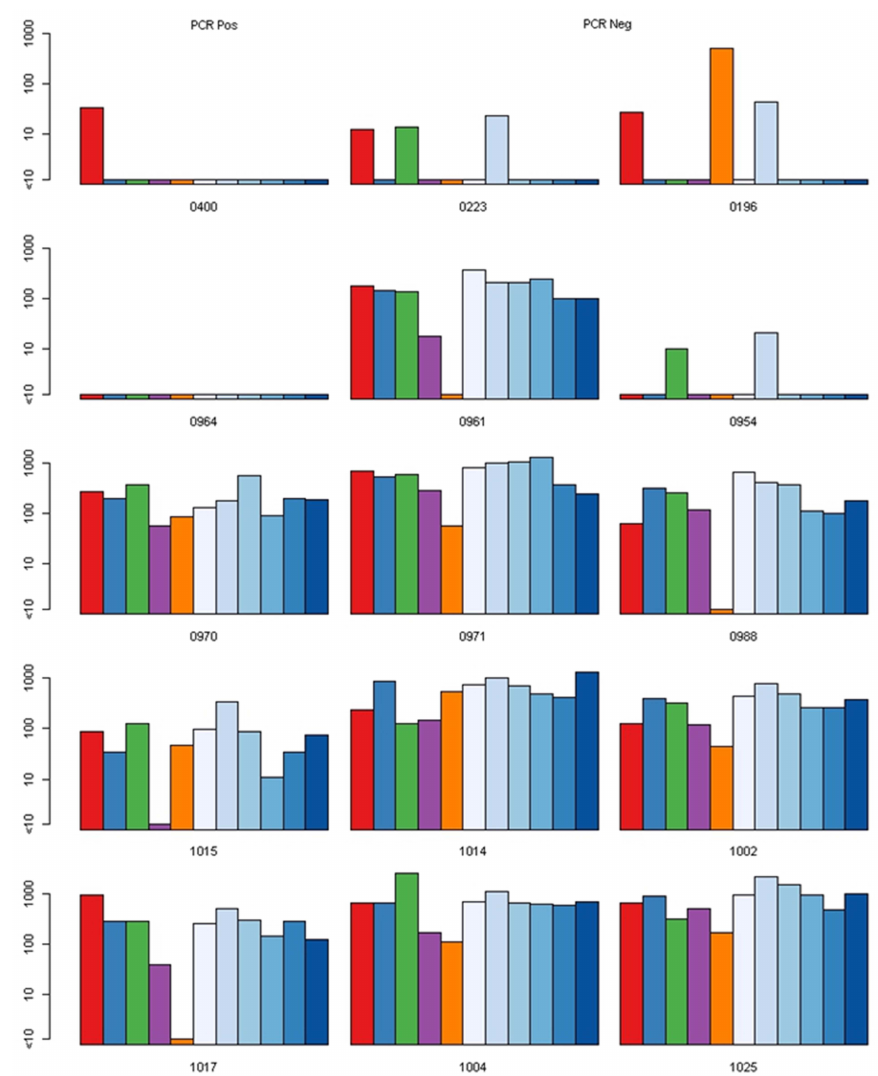
Figure 3. Pre-exposure neutralizing antibody titers (NTs) in dengue virus serotype 2 (DENV-2) ‘‘susceptible’’ and ‘‘non-susceptible’’ subjects. Each row shows one PCR positive (‘‘susceptible’’) subject and two matched PCR negative (‘‘non-susceptible’’) subjects. NTs for each subject are against (in order from left to right for each subject) the reference strains for DENV-1, -2, -3, -4 and Japanese encephalitis virus (JEV), and six different DENV-2 strains (Asian-American 1982 [ # D82-165], Asian I 1974 [ # D74-066], Asian I 1984 [ # D84-501], Asian I 1994 [ # D94-035], Asian I 2004 [ # KDS00305]), and homologous DENV-2 Asian I strains).